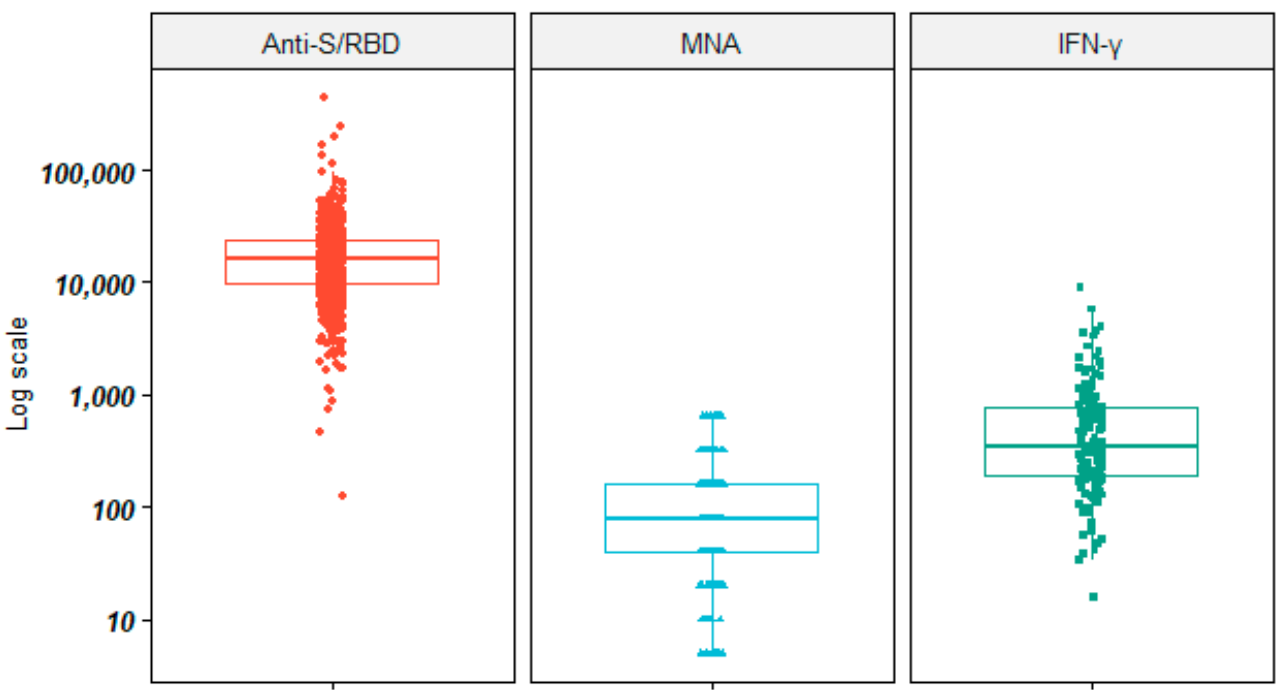
Figure 1. Overall distribution of anti-S/RBD, MNA, and IFN- γ titers elicited by BNT162b2. Legend: Anti-S/RBD: anti-Spike receptor-binding domain; MNA: Micro-neutralization assay titers; IFN: interferon. Bold line: median value. Table 1. Anti-S/RBD, MNA, and IFN- γ titers to BNT162b2 SARS-CoV-2 vaccine, according to studied variables.